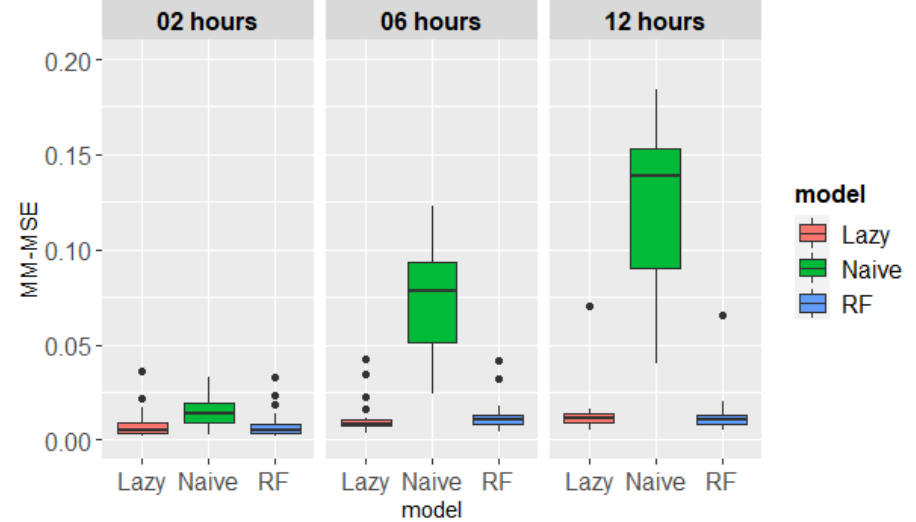
Figure 4. Visualization of MM-MSE at the changing of Forecasting